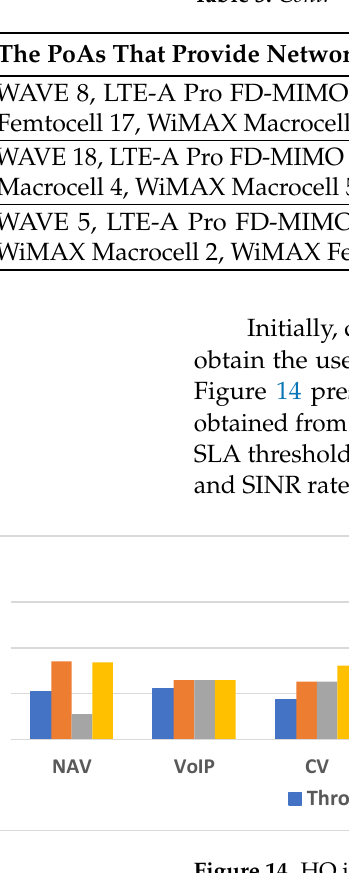
Figure 14. HO initiation weights.